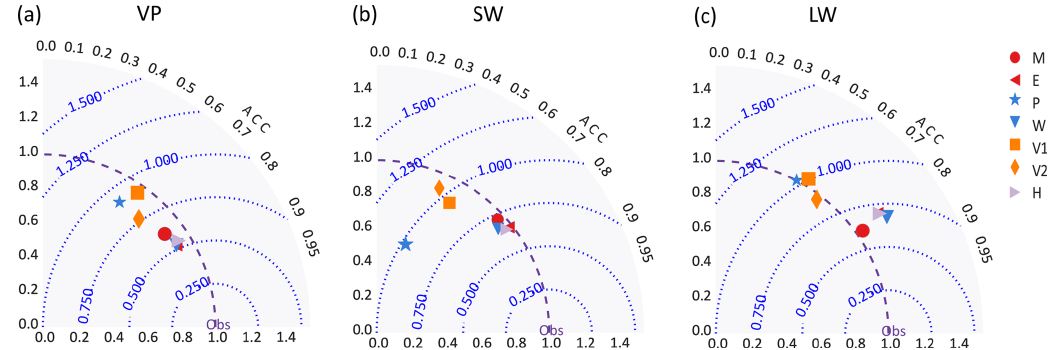
Figure 5. Taylor plots depicting the standard deviation ratio and correlation coefficients (ACCs) for the de-seasonalized time series of vapor pressure (a) , incident shortwave radiation (b) , and incident longwave radiation (c) .